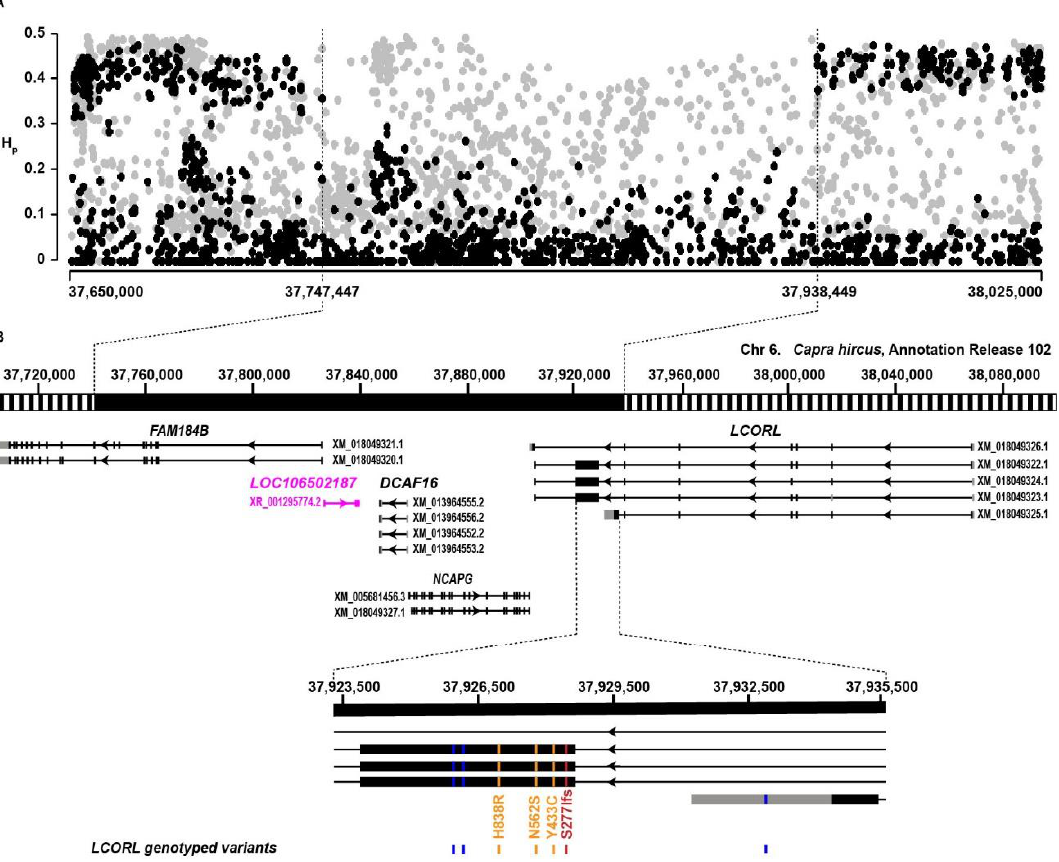
Figure 3. ( A ) Pooled heterozygosity (Hp) distribution at the LCORL locus on chromosome 6 in five medium/large-sized Pakistani goat breeds (black dots) and three small/medium breeds (grey dots). A ~191 kb region from 37,747,447 to 37,938,449 showed greatly reduced heterozygosity in the breeds with the selection signature. ( B ) The gene annotation for the selection signature is illustrated (NCBI annotation release 102). The genomic locations of seven genotyped variants in the LCORL gene are indicated in red (putative frameshift variant), orange (putative missense variants), or blue (silent or non-coding variants).